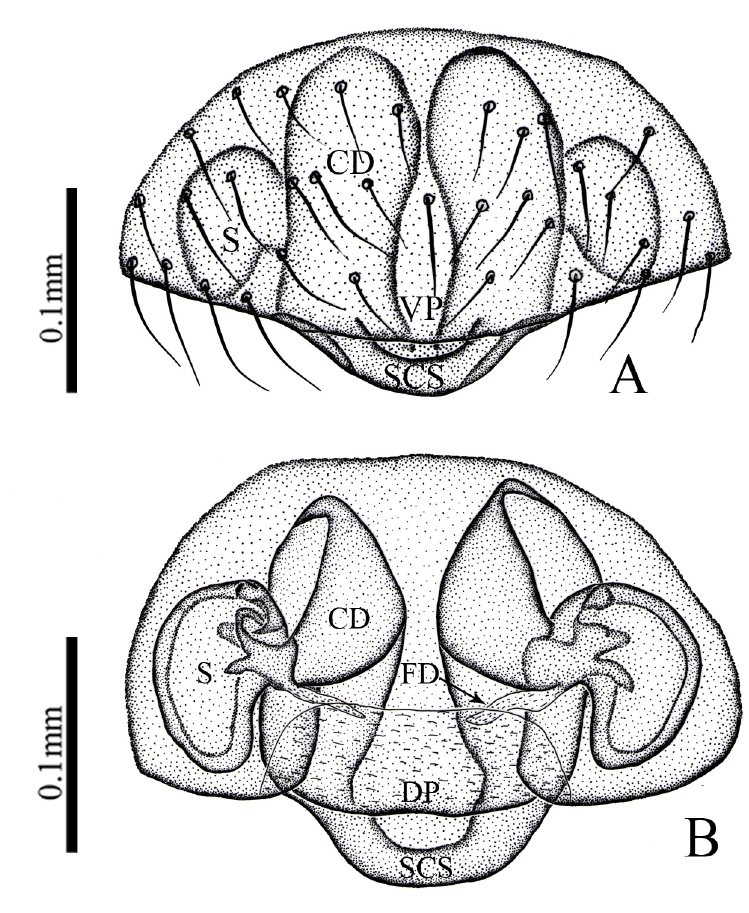
Fig. 4. Yuelushannus alatus sp. nov., female, allotype HNDWS-18-04~02. A . Epigyne, ventral view. B . Vulva, dorsal view. Scale bars: 0.1